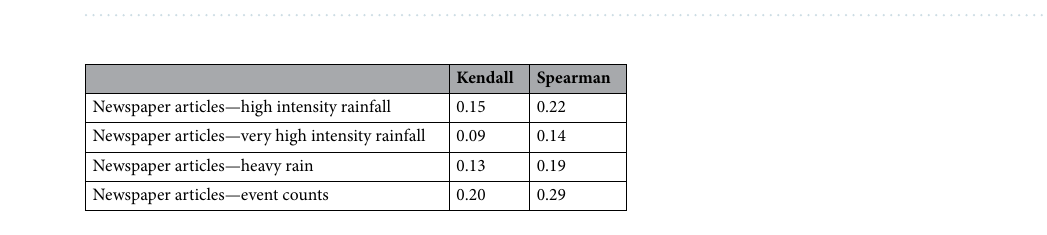
Figure 9. Distribution of “newspaper articles” with different frequencies of rainfall intensity for each WHZ. In ( a ) “newspaper articles” and “high” intensity; ( b ) “newspaper articles” and “very high” intensity; ( c ) “newspaper articles” and “heavy rain”; ( d ) the correlation between “newspaper articles” and the events count.